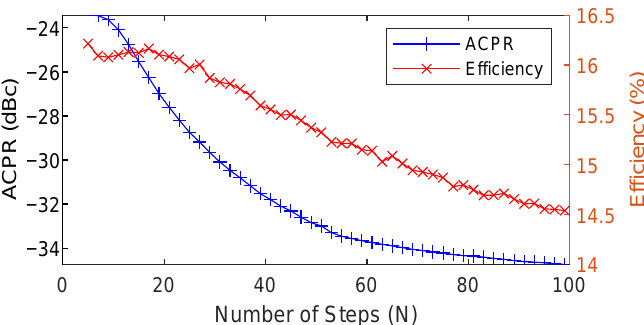
Figure 3. ACPR and efficiency performance of the ET PA with the NR-60 MHz OFDM-like signal, using the SR envelope with p = 1, OP = 0.2, and different N (number of steps)